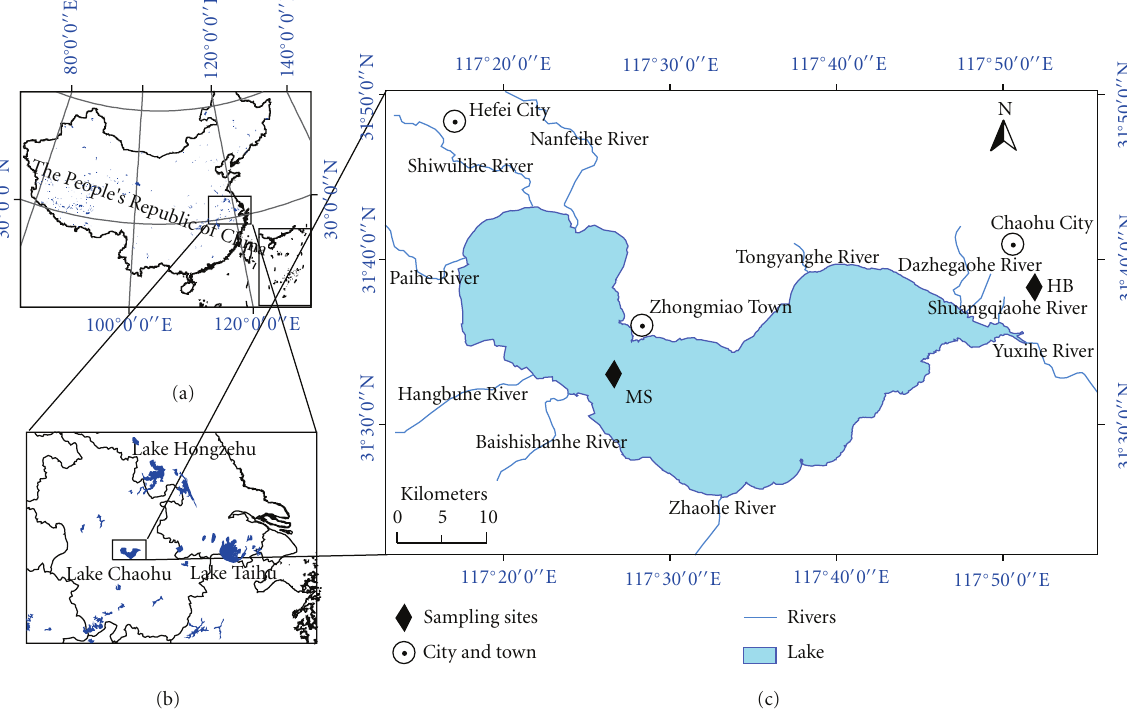
Figure 1: Geographical locations of (a) Lake Chaohu in China, (b) Lake Chaohu in Eastern China, and (c) the sampling sites.